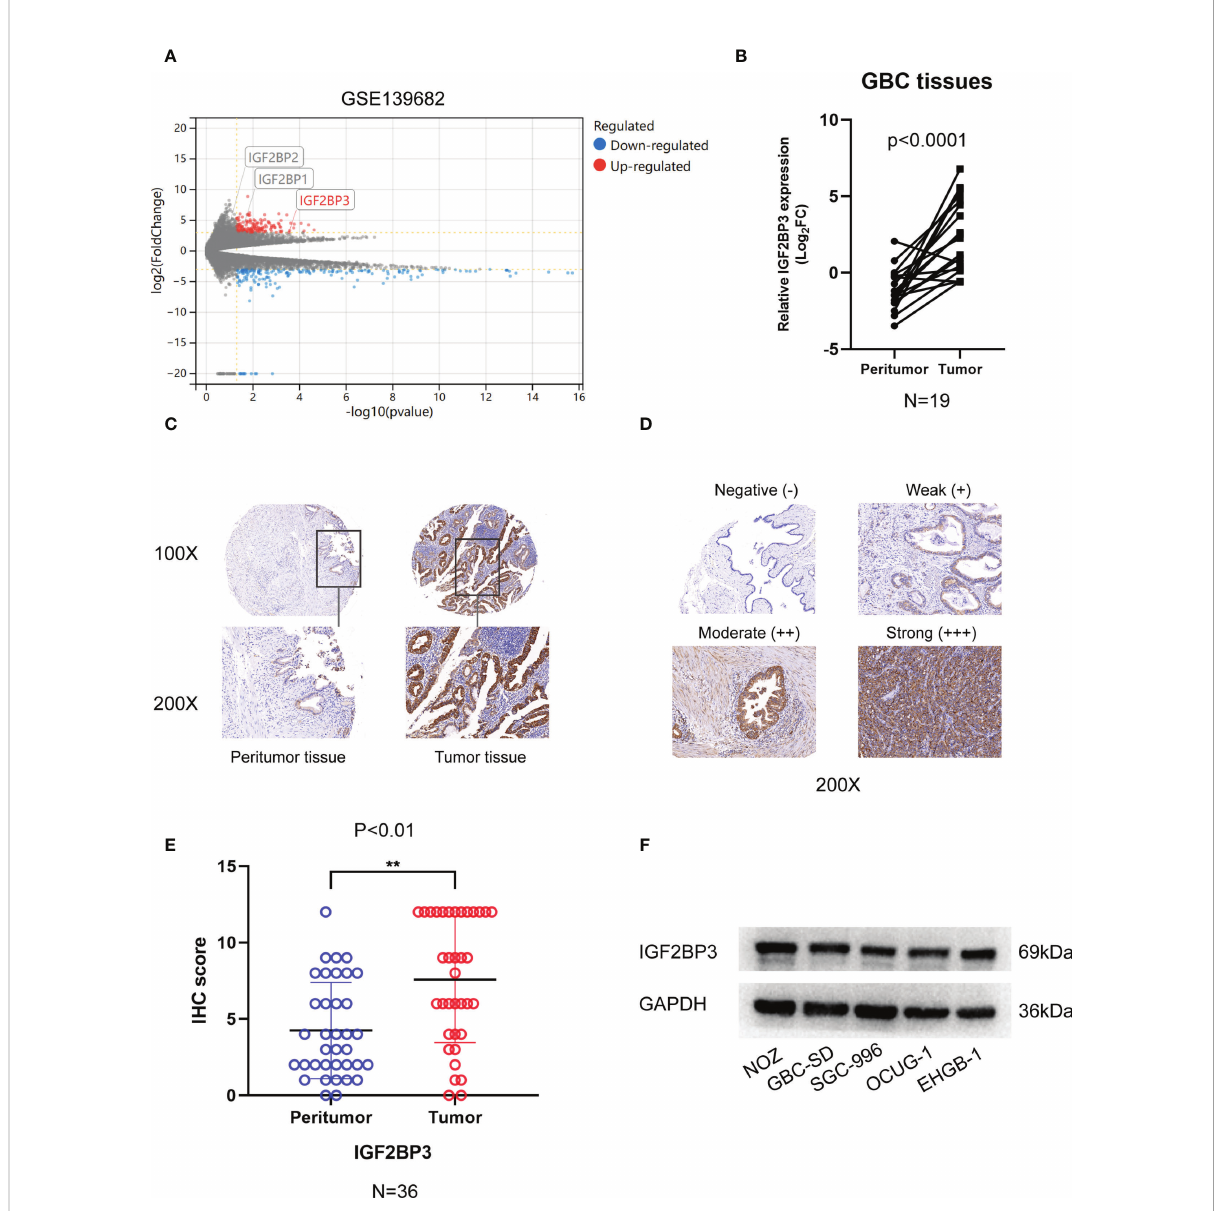
FIGURE 1 The expression of IGF2BP3 in GBC tissues. (A) Volcano plots showed the differentially expressed genes of GBC in GSE139682. (B) 19 pairs of GBC tumor tissues and peritumoral tissues were subjected to qPCR to detect the expression levels of IGF2BP3. (C) Representative IHC staining images are shown to illustrate differential expression in GBC tissue and paired peritumoral tissue. Bar:100 m m. (D) Representative image shows negative, weak, moderate, and strong expression of IGF2BP3 in IHC of GBC tissues. The bottom images represent ampli fi ed regions shown in square boxes in the top images Scale bar: 100 m m. (E) IHC scores of peritumoral tissues and GBC tissues. (F) The protein expression of IGF2BP3 in GBC cell lines was detected by western blotting. Paired t test was used in (B) Unpaired t test was used in (E) Data is shown as mean ± SD, ** P <